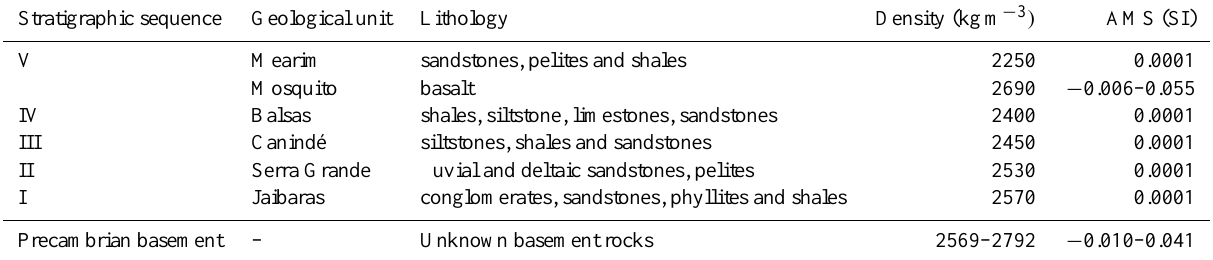
Table 2. Bodies used in 2-D geophysical profile models. AMS: assigned magnetic susceptibility (mathematical representation that incorpo- rates both magnetic susceptibility and a remnant component, if